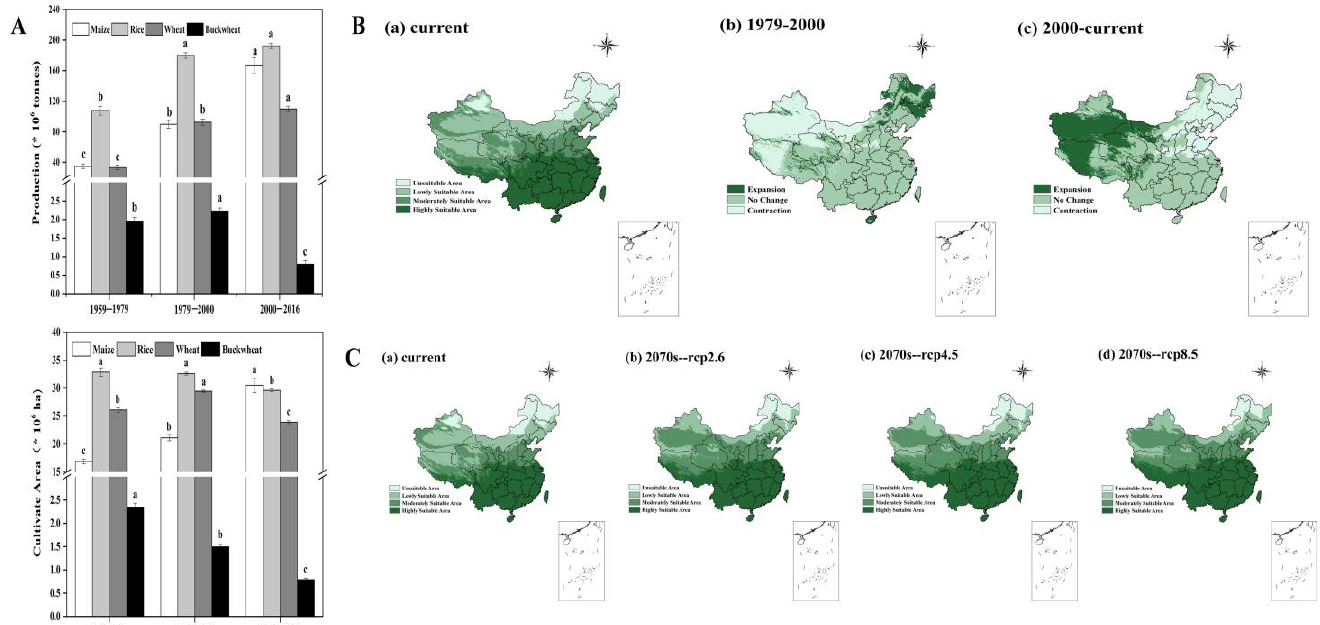
Figure 4. The development of buckwheat cultivation and its potentially suitable areas in the future. ( A ) represents the production and cultivated areas of major crops and buckwheat in 1979–2016; values are means ± SE and different lowercase letters in each crop indicate the significant differences between different patterns (ANOVA followed by the Duncan test, p < 0.05). ( B ) represents the changes in buckwheat cultivation and in the potentially suitable areas in 1979–2016. ( C ) represents the potentially suitable areas of buckwheat cultivation in the current day and